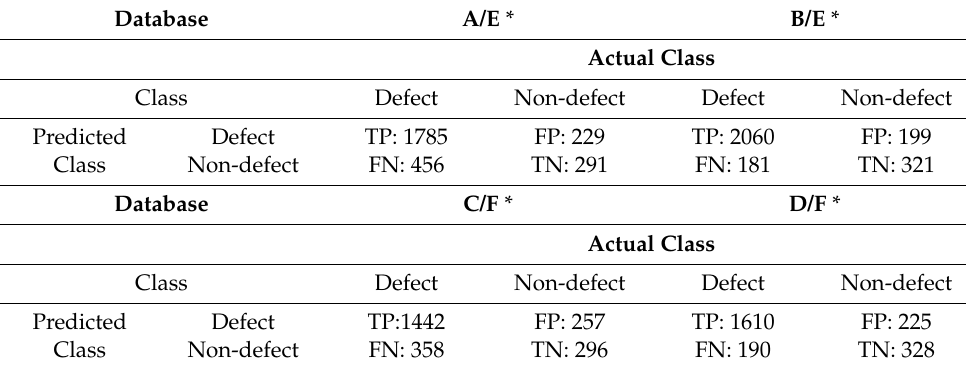
Table 1. Class mark list—comprehensive results.